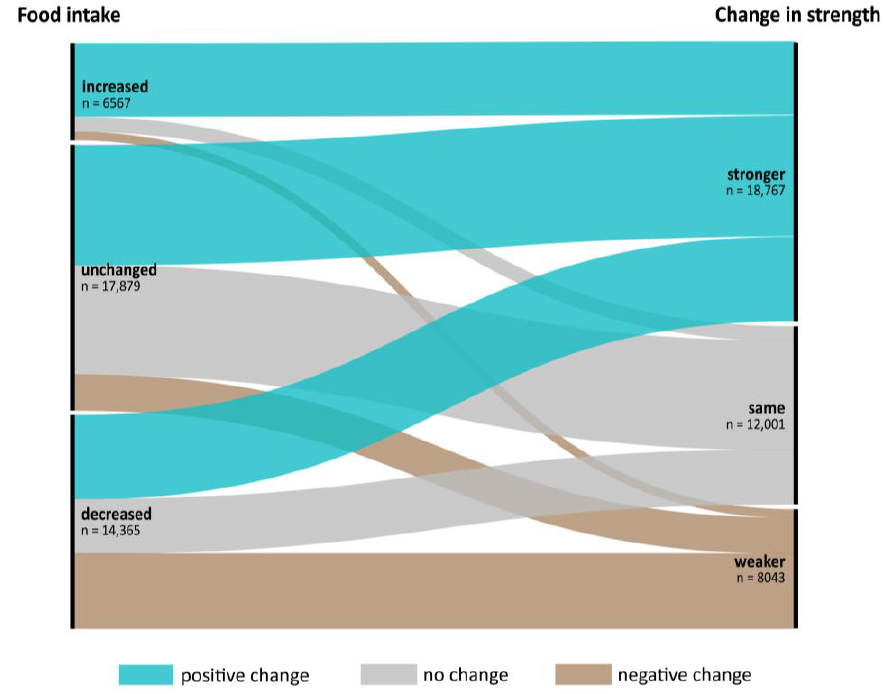
Figure 4. Change of food intake versus change in strength between admission and nutritionDay ( n = 38,811), categories “I don’t know” and “missing” are excluded from the graph.